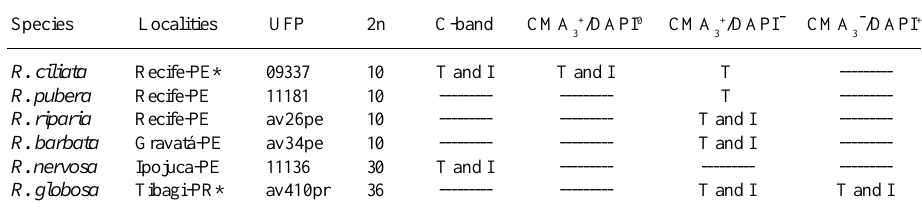
Table I - Type and distribution of heterochromatin blocks on chromosomes of six species of Rhynchospora . Species